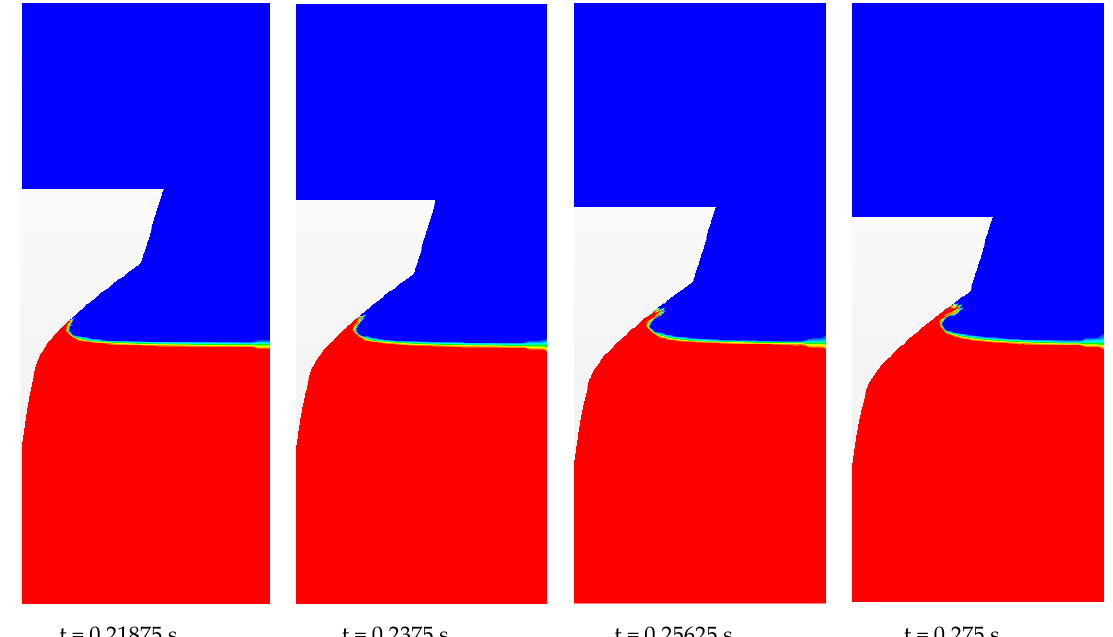
Figure 13. Free surface evolution during the water entry of the original section “S2”.